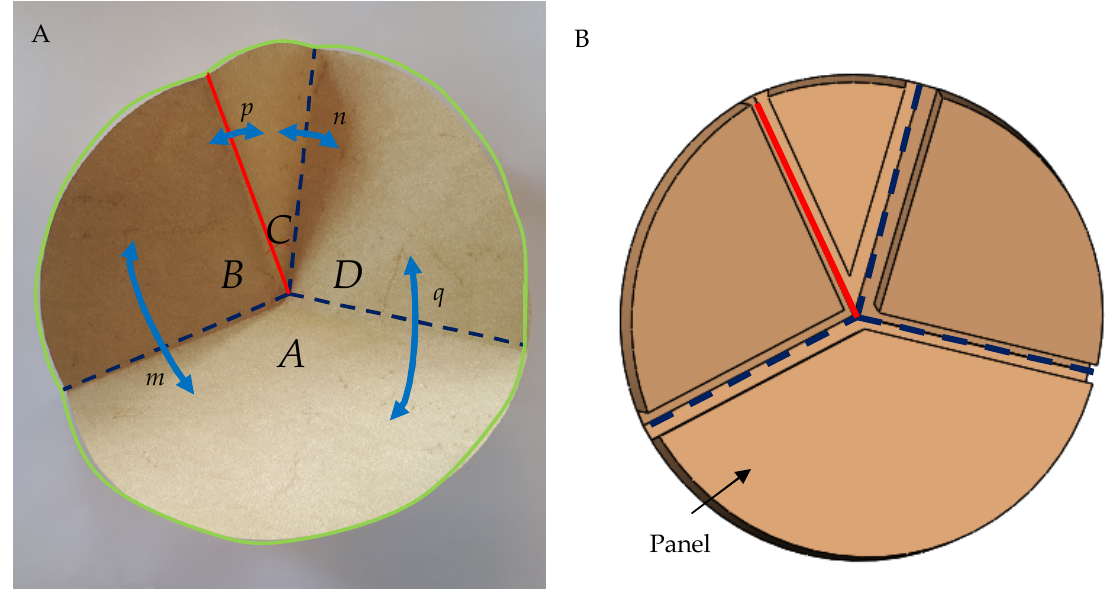
Figure 5. Origami model: ( A ) A half-folded paper model showing the scheme of the angles between the creases ( A , B , C , and D ) and the dihedral angles ( m , n , p, and q ) of a fold with creases that intersect in a vertex. The valley and mountain folds are marked by blue dashed lines and continuous red lines, respectively. ( B ) Rigid origami – the panels are thick and do not bend during folding.